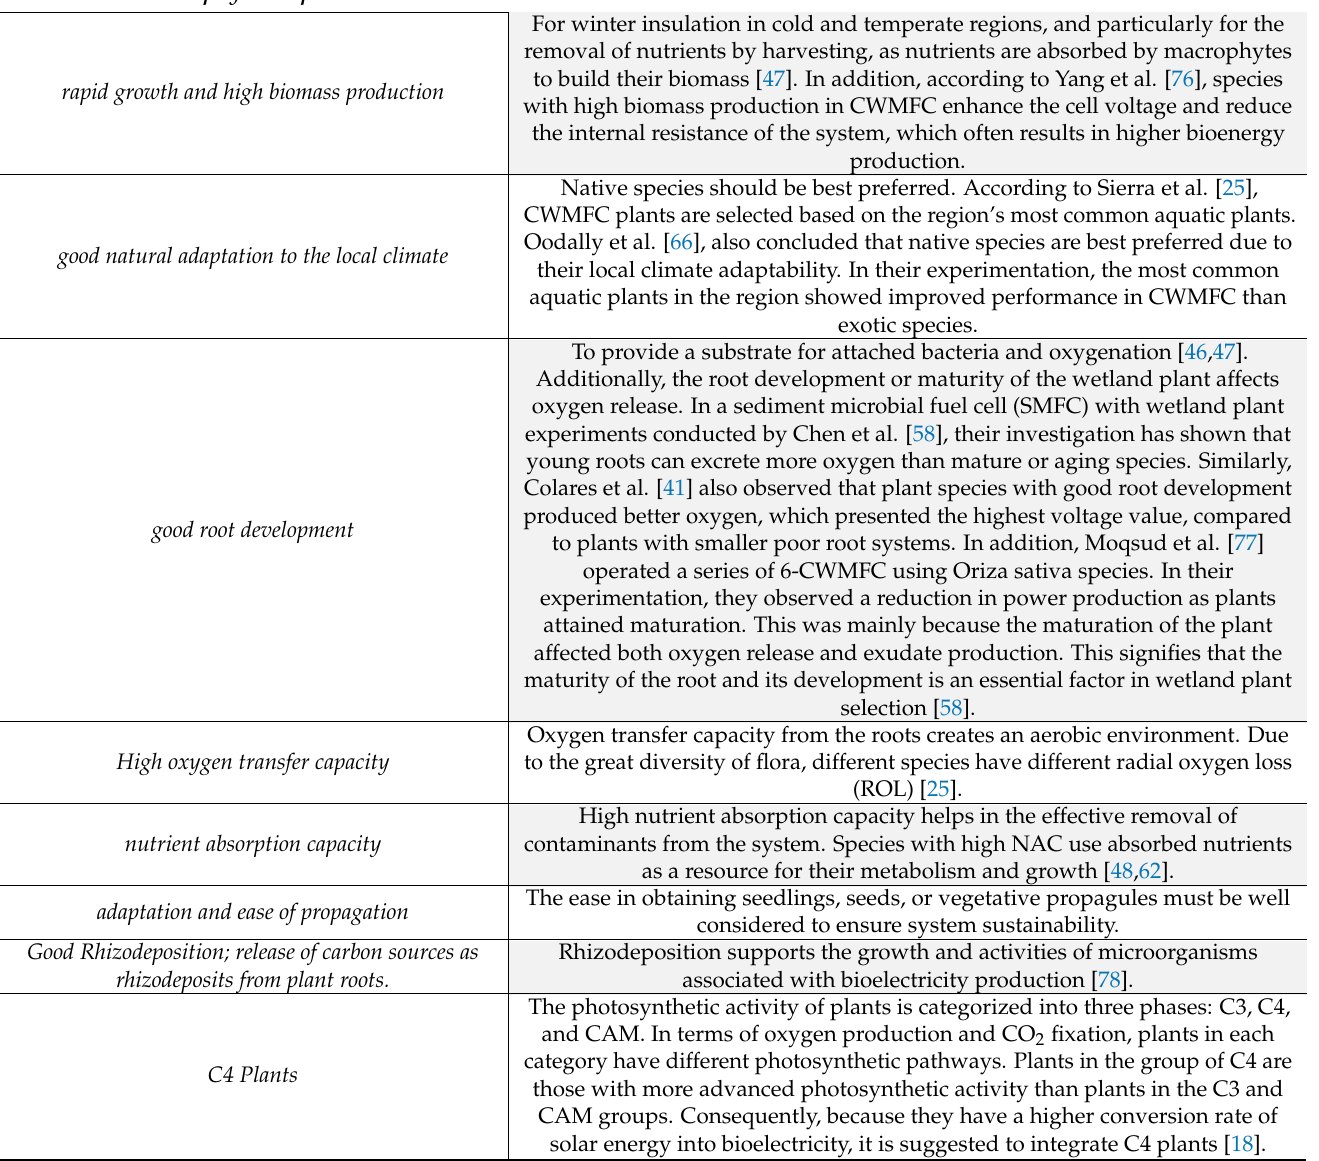
Table 2. Characteristics of macrophytes and their relevance in